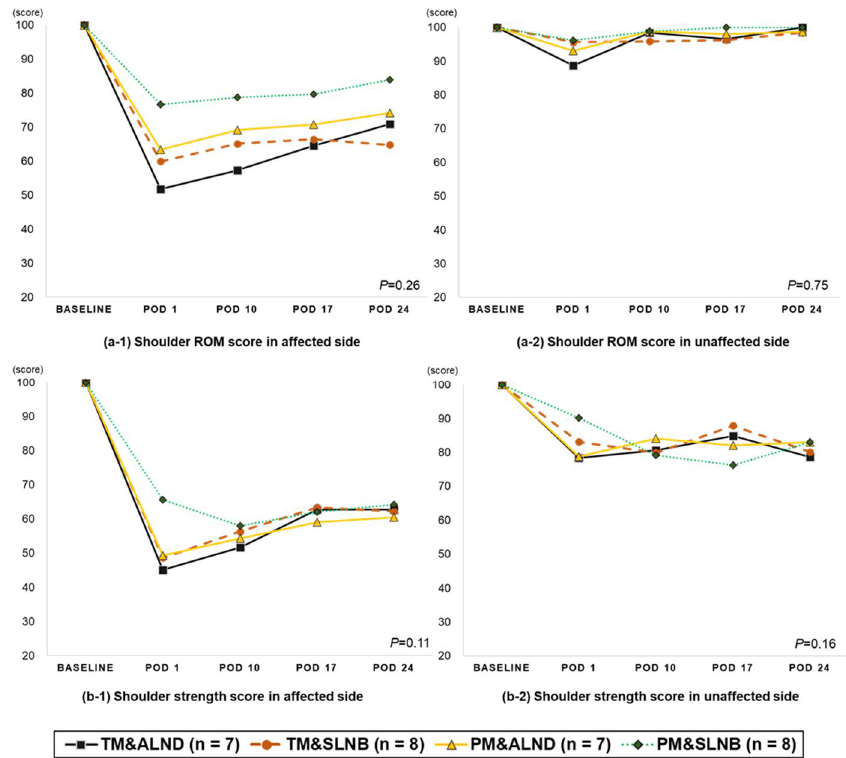
Figure 3. The changes in the shoulder function score in breast cancer patients after surgery according to the surgery type (descriptive) . P : the repeated measure of ANOVA analysis (group*time interaction). Abbreviation: Total mastectomy with axillary lymph node dissection; TM with ALND, Total mastectomy with sentinel node biopsy; TM c SLNB, Partial mastectomy with axillary node dissection; PM with ALND, Partial mastectomy with sentinel node biopsy; PM with SLNB, Postoperative day: POD.